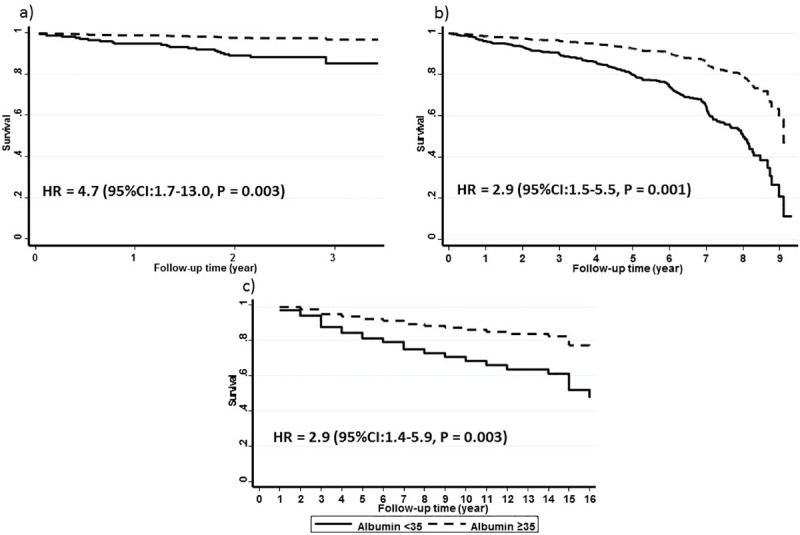
Low serum albumin (<35 g/L solid line) predicts higher mortality among sickle cell disease patients in a) Walk-PHaSST b) CSSCD and c) OMG-SCD cohorts. Graphs show the age and hemoglobin adjusted survival in each cohort.